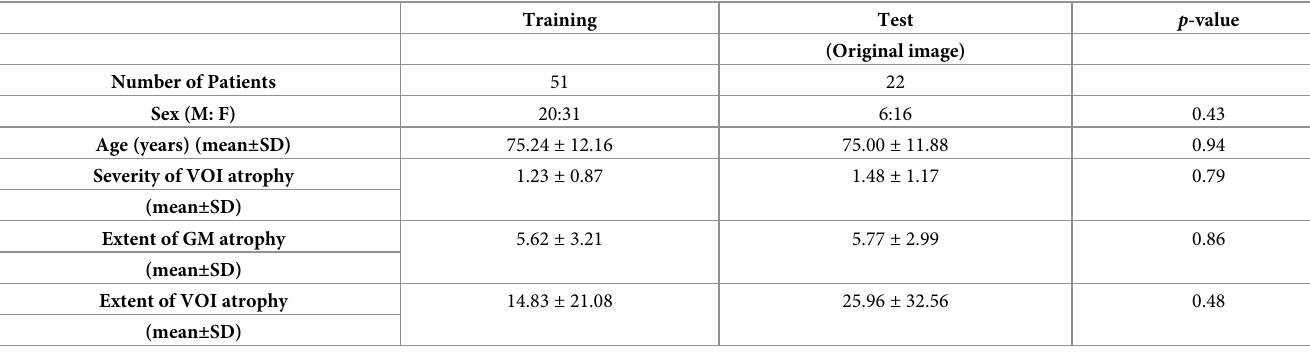
Table 1. Details of the training and test groups.